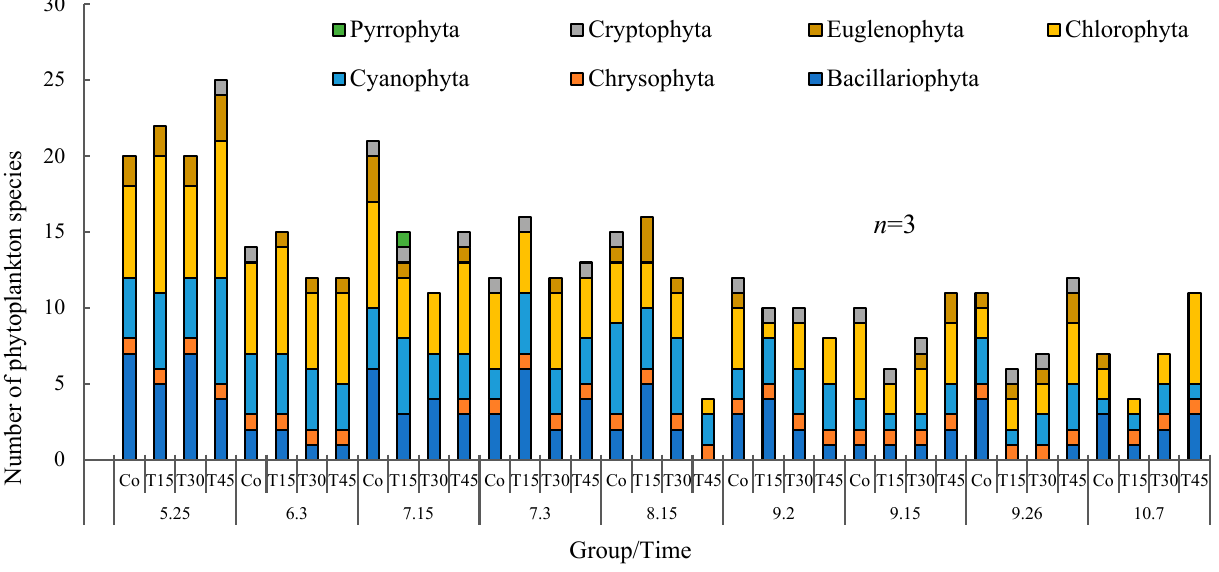
Figure 3. Water quality parameters of each enclosure during the experiment. The y -axis of NO 2 − -N is the secondary coordinate axis (right), and others correspond to the left primary coordinate axis.